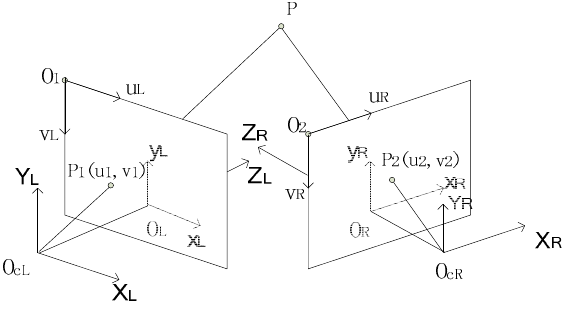
Figure 4. Pinhole imaging model of the binocular vision system.